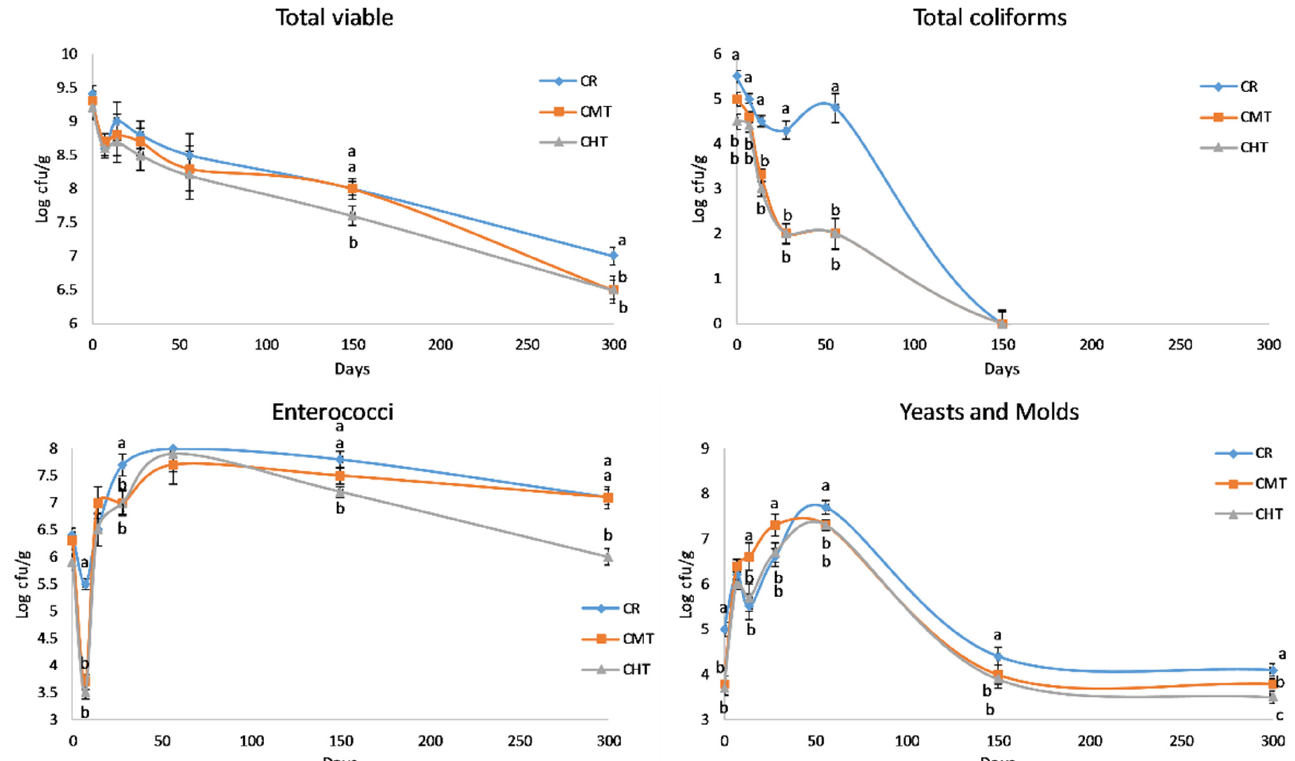
Figure 5. Counts of the non- lactic acid bacteria groups (cfu/g) in Canestrato Pugliese cheeses made from raw (CR), mild-thermized (CMT) and high-thermized (CHT) milk during ripening (0–300 days). Mean values of two analyses on two cheese wheels for each type of cheese.